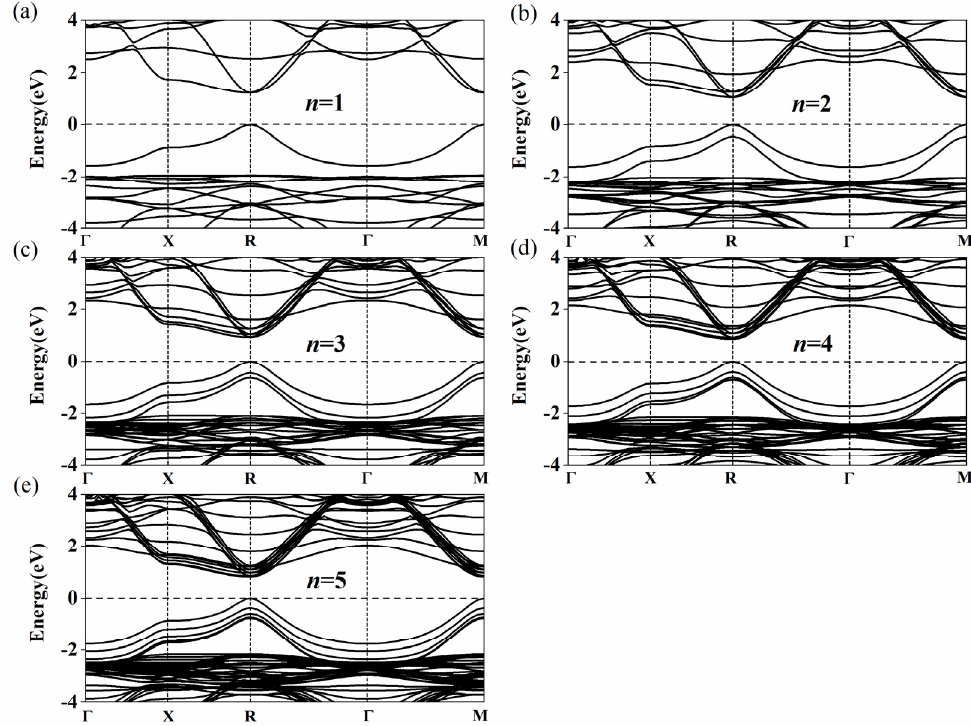
Figure 3. Calculated band structures of Cs n +1 Sn n Br 3 n +1 for ( a ) 1 layer, ( b ) 2 layers, ( c ) 3 layers, ( d ) 4 layers and ( e ) 5 layers. The CBM and the VBM appear at the R point (0.5 0.5 0.5). The high symmetry path is assumed with respect to the Brillouin zone center Γ with the coordinates (0, 0, 0) to X (0, 0.5, 0), R (0.5, 0.5, 0.5), Γ (0, 0, 0) and M (0.5, 0.5, 0).